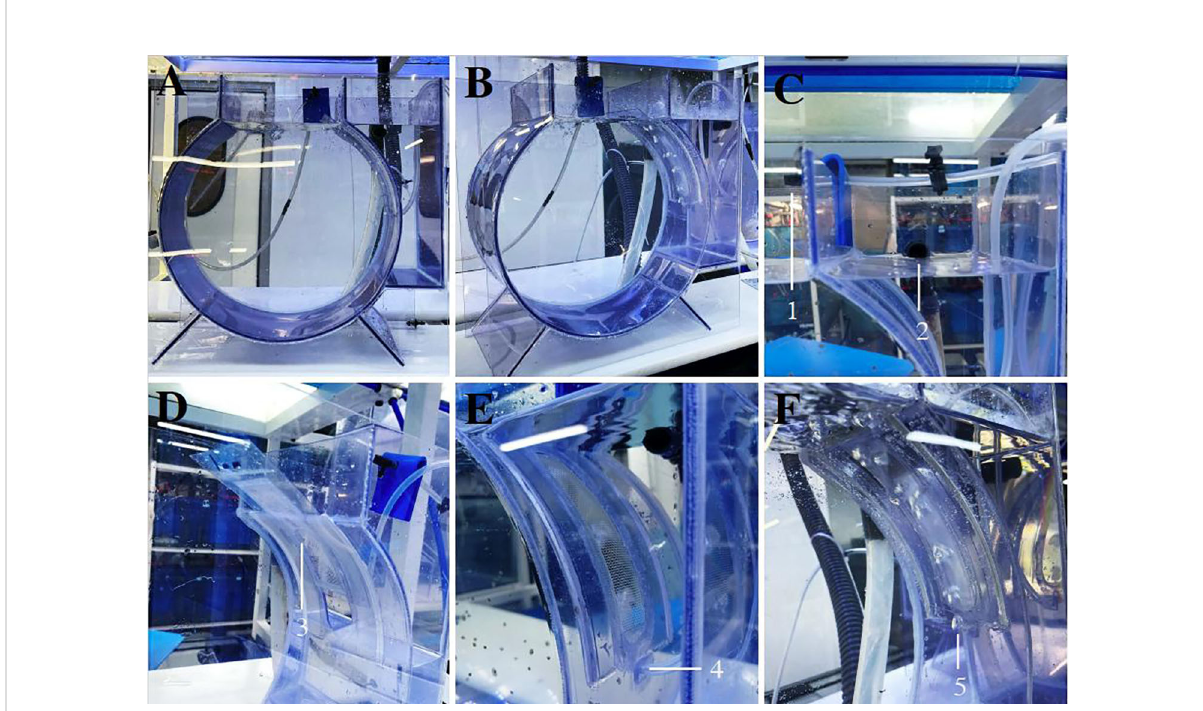
FIGURE 2 Aquarium for the growth out of the early jelly fi sh life stages: (A, B) Frontal view. (C) Drainage chamber. (D) Interchangeable mesh screen (150, 250, 350 and 500 µm and 1 mm). (E) Air inlet in the main chamber. (F) Air bubbles covering the interchangeable mesh screen. Aquarium con fi guration: 1, water inlet; 2, water outlet; 3, interchangeable mesh screen; 4, air inlet; 5, air